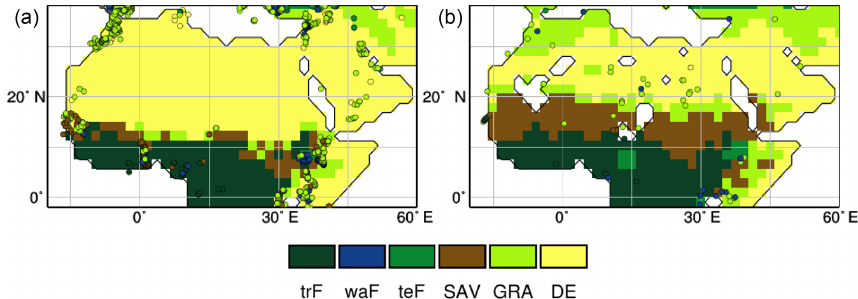
Figure 2. Biomes determined from simulated vegetation cover fractions and PFT cover fractions applying the method of Dallmeyer et al. (2018) for 0k (a) and 6k (b) . The circles indicate biomes reconstructed from pollen data of the BIOME 6000 database (Harrison, 2017). The white areas within the continent are lakes. (trF: tropical forest, waF: warm-mixed forest, teF: temperate forest, SAV: savanna, GRA: grassland, DE: